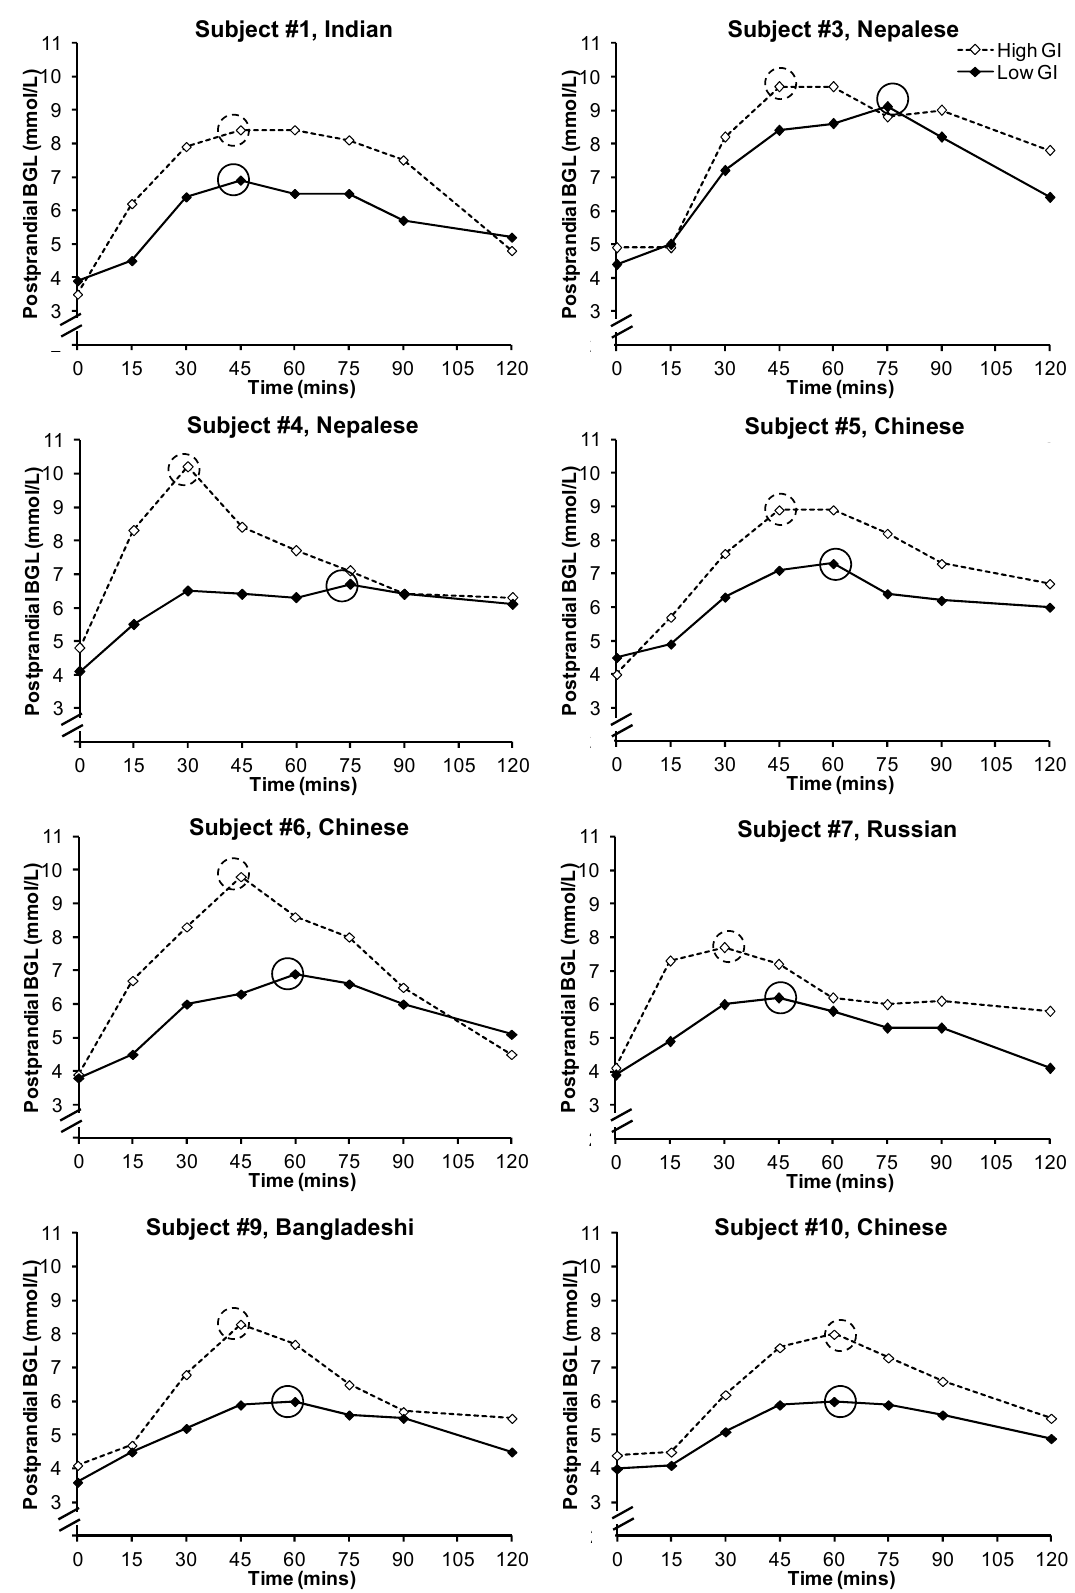
Figure 2. Postprandial glycemic responses of the subjects after the consumption of a low or high glycemic index breakfast. Peak blood glucose levels were circled. Subjects #2 and #8 withdrew after the first test session and hence their individual data were not